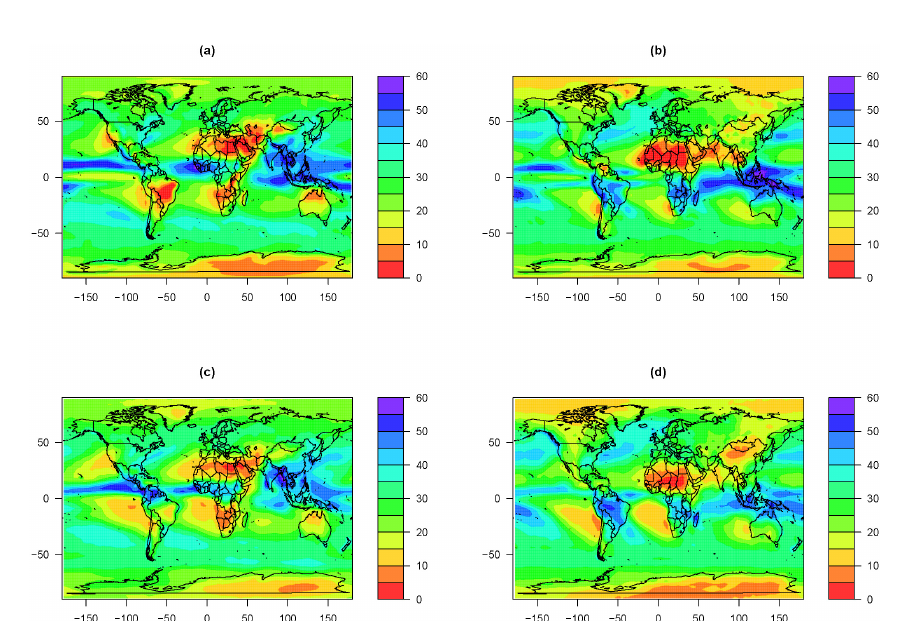
Figure 2. 1000 (precipitation) 1 / 3 from GFDL for (a) JJA and (b) DJF, and from GPCP for (c) JJA and (d) DJF. Precipitation values are in kilograms per square meter per second.